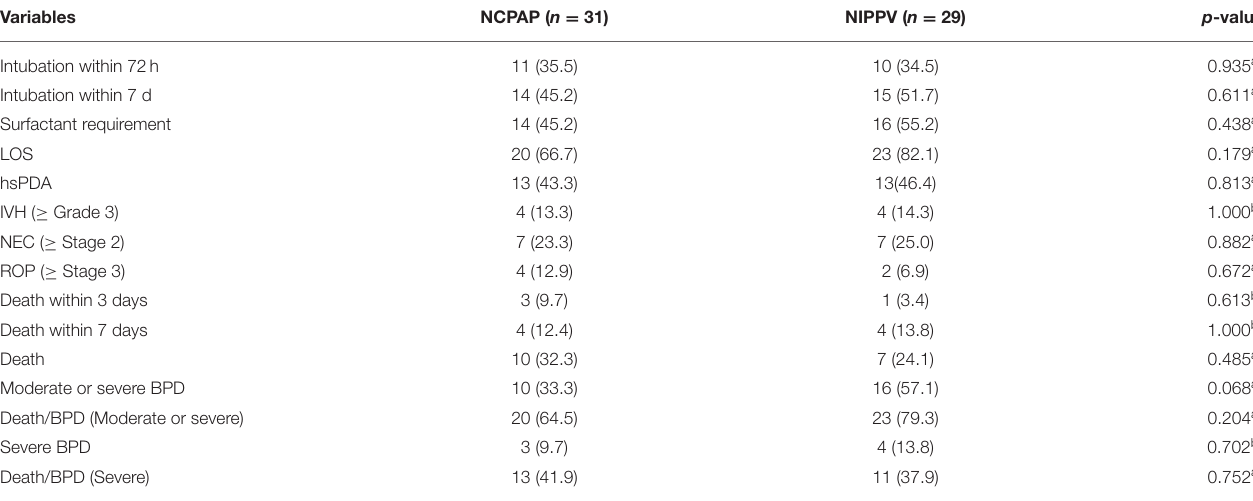
TABLE 3 | Primary and secondary outcomes.